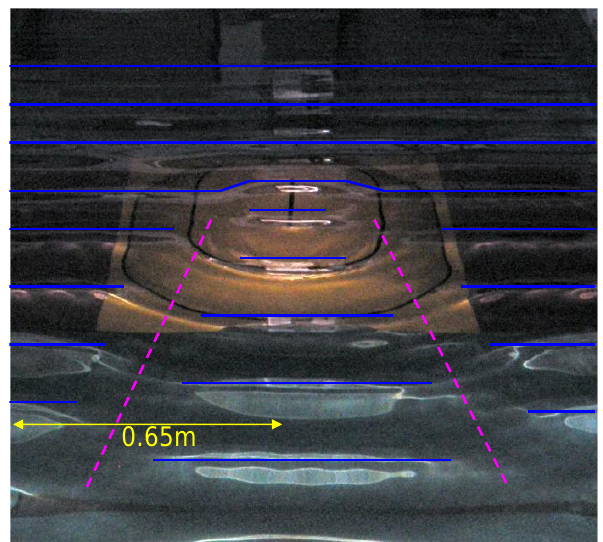
Fig. 6: Photograph of the free surface for run 7, T=0.5s